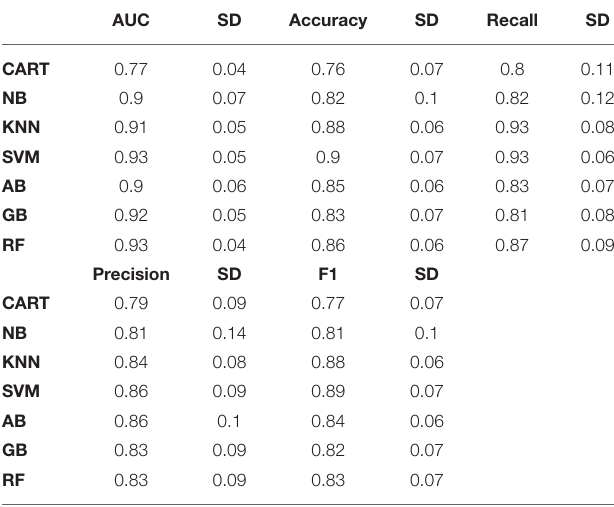
TABLE 1 | Computational